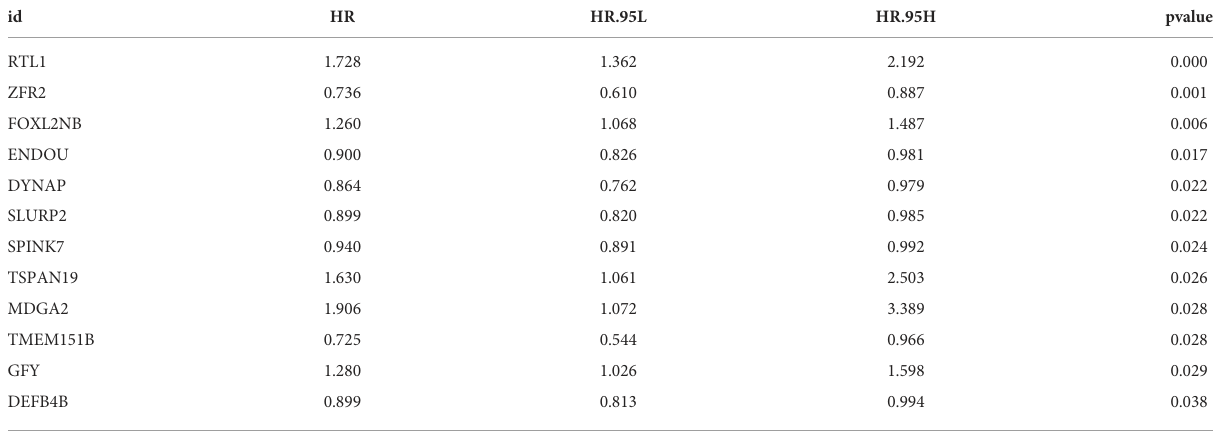
TABLE 2 Prognosis-related genes identi fi ed by univariate Cox regression analysis.